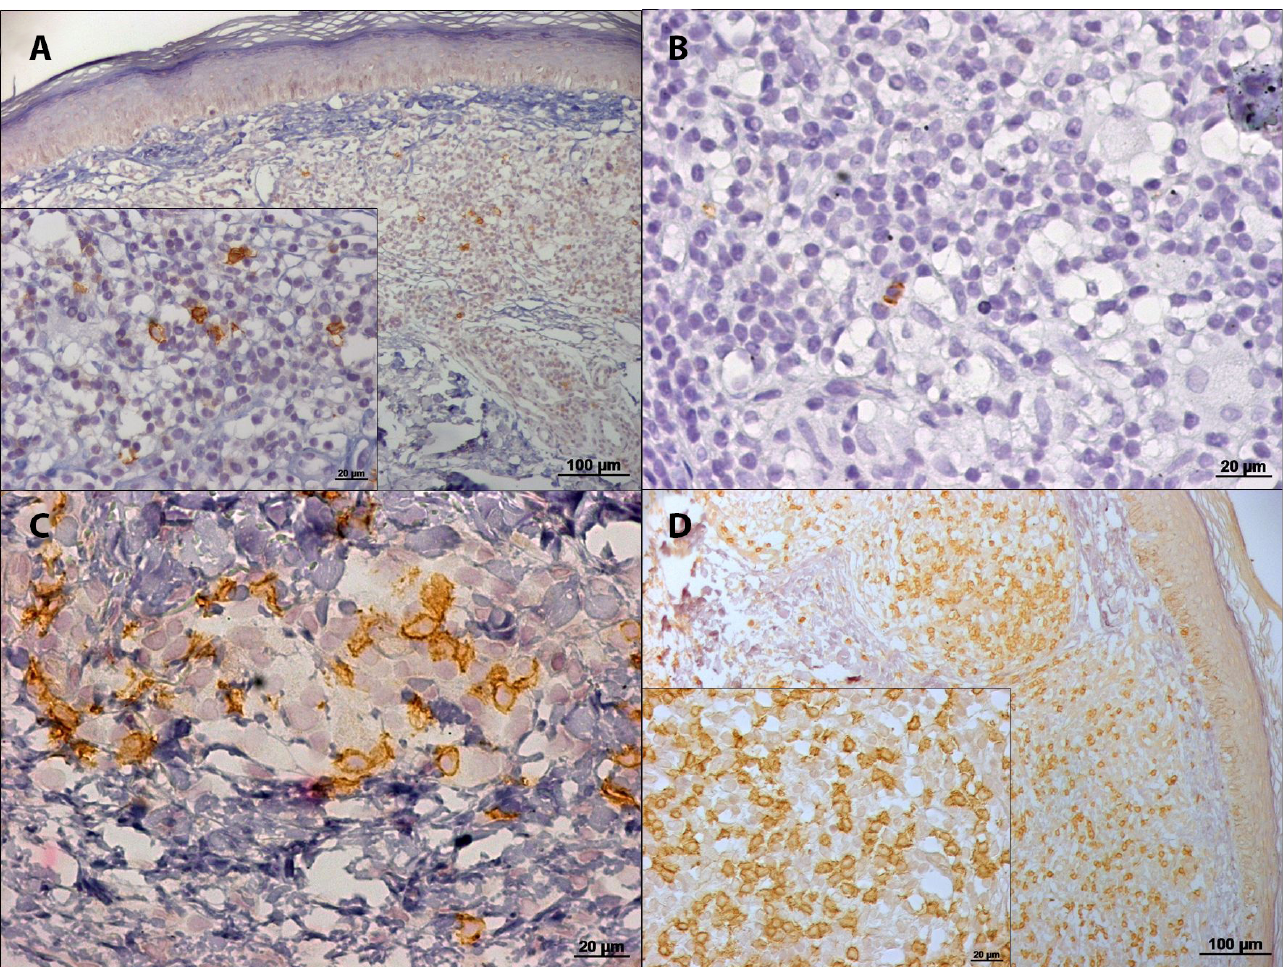
Figure 2. Photomicrographs of immunohistochemistry reaction in histological sections of skin lesions of patients with non-ulcerated or atypical cutaneous leishmaniasis showing in the dermal inflammatory infiltrate: (A) B lymphocytes (CD20 + ); (B) NK cells (CD56 + ); (C) CD4 + T lymphocytes and (D) CD8 + T lymphocytes.